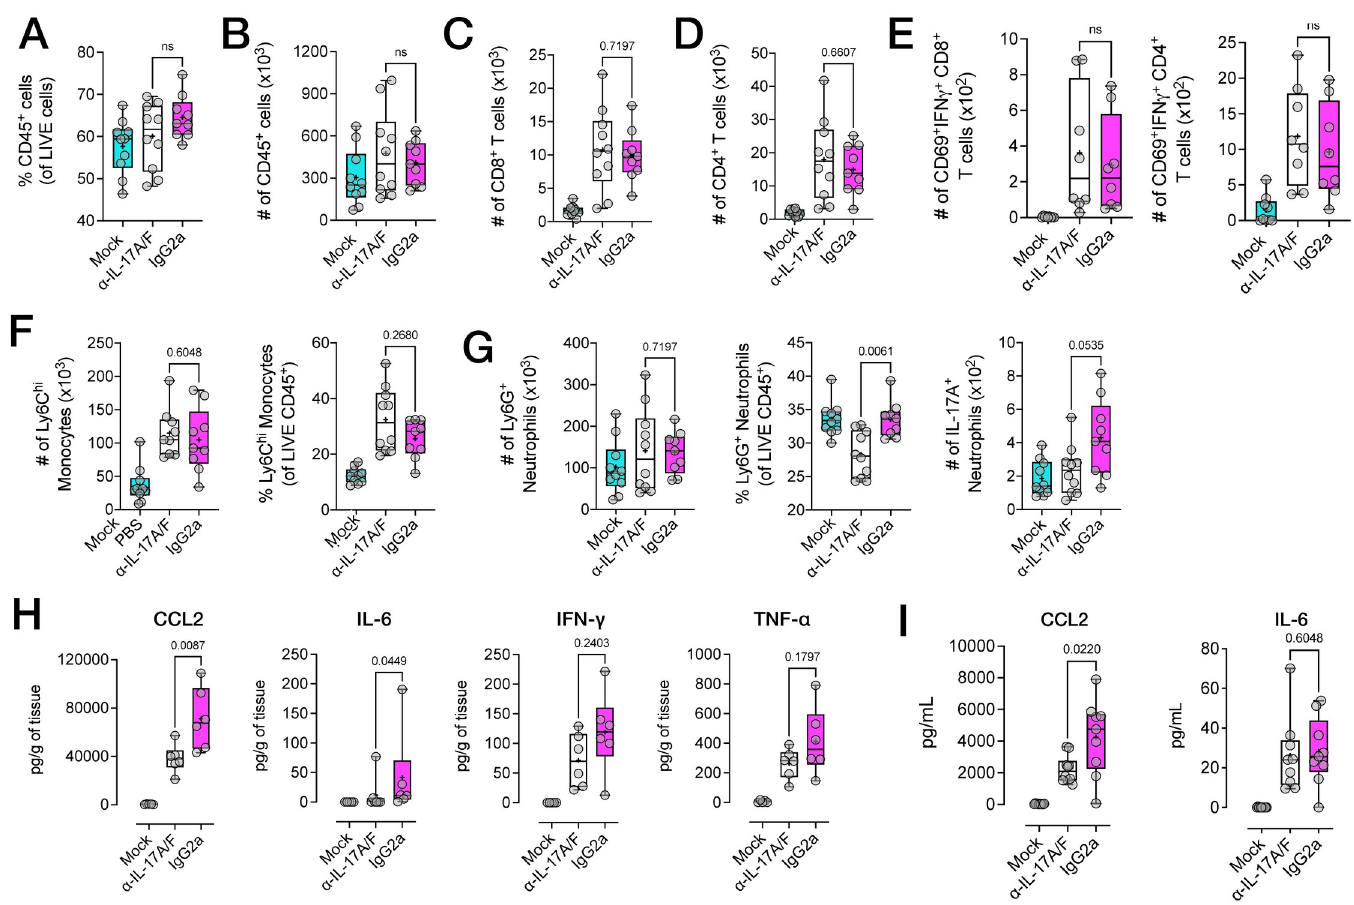
Fig 9. Modulation of IL-17 in RRV disease disrupts myeloid, but not lymphoid cell infiltration into the joint tissue. A) Proportions and B ) numbers (of total LIVE cells) for infiltrating CD45 + , C ) CD8 + and D) CD4 + T cells (gated from LIVE CD45 + Ly6G - CD11b - CD3 + cells) in the feet of RRV-infected C57BL/6J mice treated with anti-IL-17A/F mAb at 10 dpi. E ) Numbers of activated CD69 + IFN γ + CD8 + and CD4 + T cells in the feet of RRV-infected C57BL/6J mice treated with anti-IL-17A/F mAb at 10 dpi. F) Total number and proportions (% of LIVE CD45 + cells) of inflammatory Ly6C hi monocytes and G) total numbers and proportions (% of LIVE CD45 + cells) of Ly6G + neutrophils in the feet of RRV-infected mice treated IL-17A/F mAb at 10 dpi. Data presented as numbers (per paired feet) of LIVE CD45 + Ly6G - CD11b + Ly6C hi for monocytes, and LIVE CD45 + Ly6G + for neutrophils, respectively H ) Number of IL-17A + neutrophils in the feet of RRV-infected mice treated IL-17A/F mAb at 10 dpi. Data presented as absolute cell numbers of LIVE CD45 + CD3 - Ly6G + IL-17A + cells. Data in A - G shown as box-whiskers plots (bar shows median, + shows mean, error bars show range), presented as mean +/- SEM (n = 5 mice per group, NE = 2). Statistically significant differences between groups determined with Mann-Whitney U test, p values indicated on plots. I) Soluble cytokine protein levels in the feet of RRV-infected C57BL/6J mice treated with anti-IL-17A/F mAb or IgG2a isotype, at 10 dpi. Data normalised to tissue weight and shown as pg/gram of tissue (pg/g). J) Serum levels of CCL2 and IL-6 of RRV-infected C57BL/6J mice treated with anti-IL-17A/F mAb or IgG2a isotype, at 10 dpi. Data presented as pg/mL. Data shown as box-whiskers plots (bar shows median, + shows mean, error bars show range), presented as mean +/- SEM, (n = 5 mice per group, NE = 2). Statistically significant differences between groups determined with Mann-Whitney U test, p values indicated on graphs.